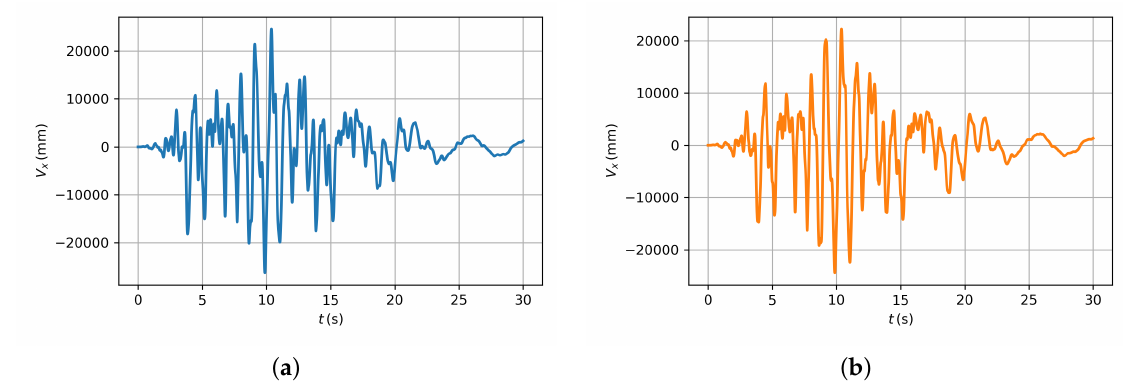
Figure 6. Base shear in x direction in the full F.E.M. model ( a ) and in the Timoshenko beam model ( b